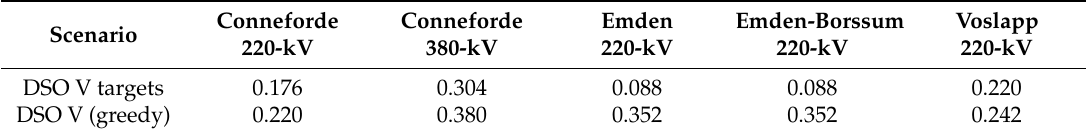
Table 7. Absolute average voltage error at each CP